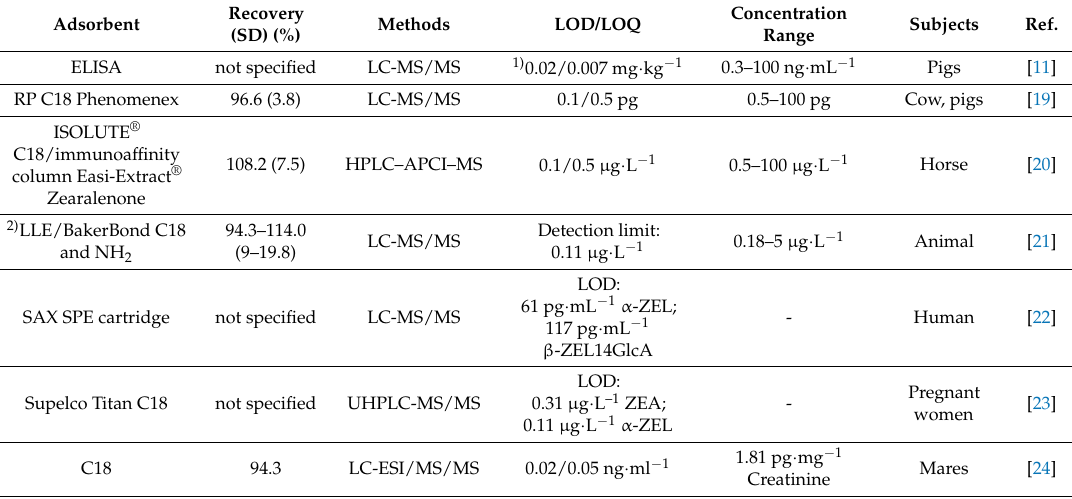
Table 1. The effectiveness of ZEA sorption from urine by various